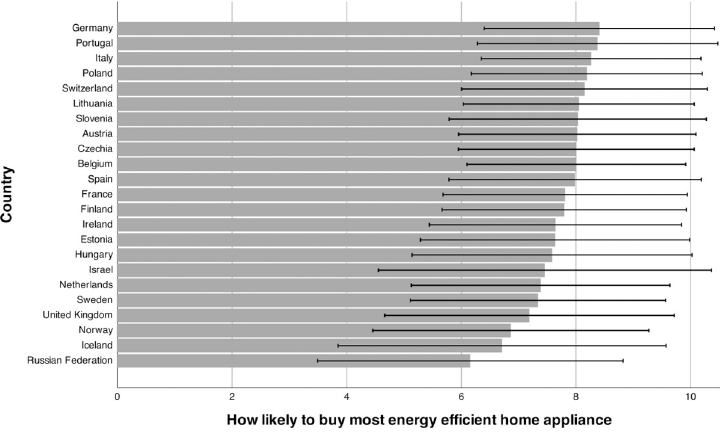
Fig 2. Mean energy efficiency behavior. Note. Means weighted with a combination of post-stratification weights and population weights. The figure includes +/- 1 SD.